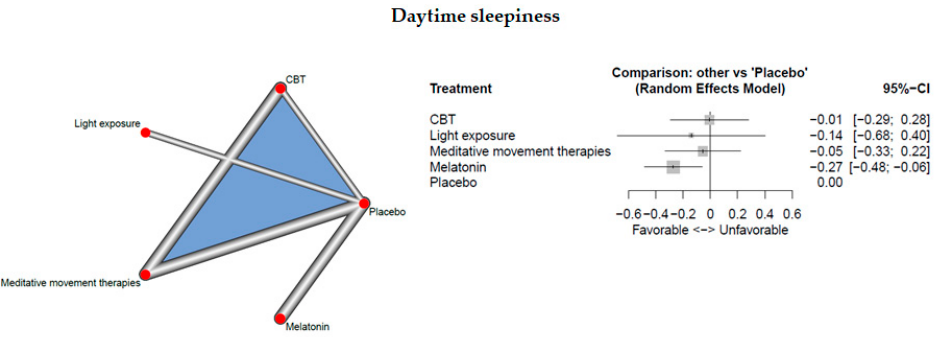
Figure 6. Daytime sleepiness .